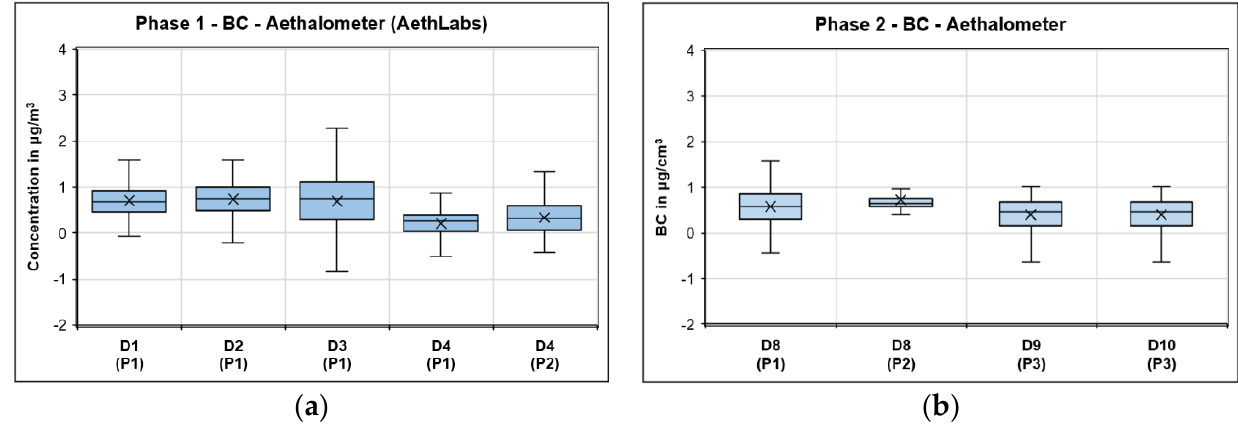
Figure 21. BC peaks on ( a ) day 11 and ( b ) day 13 at point 3. 3.1.5. Nitrogen Oxides (NO and NO 2 ) The NO x monitor was introduced in phase 2 starting on day 9 (Figure 22a) with five peaks being measured from the aircrafts. The inconsistent wind direction on day 10 (Fig- ure 22b) likely negatively affected the NO 2 measured and no significant peaks were ob- served on that day. During phase 3, the NO and NO 2 peaks from aircrafts on nine of the ten days could be measured. The levels were similar to those in phase 2 and in only two instances were the concentrations above 120 ppb; all other peaks caused by aircrafts were quite moderate. Figure 23a shows that on day 14, there were NO and NO 2 peaks throughout the duration of the measurement, while on day 18 (Figure 23b), they were only captured towards the end of the measurement period due to the inconsistent wind direction. ( a ) ( b ) Figure 22. NO 2 concentration at point 3 on ( a ) day 9 and ( b ) day 10.